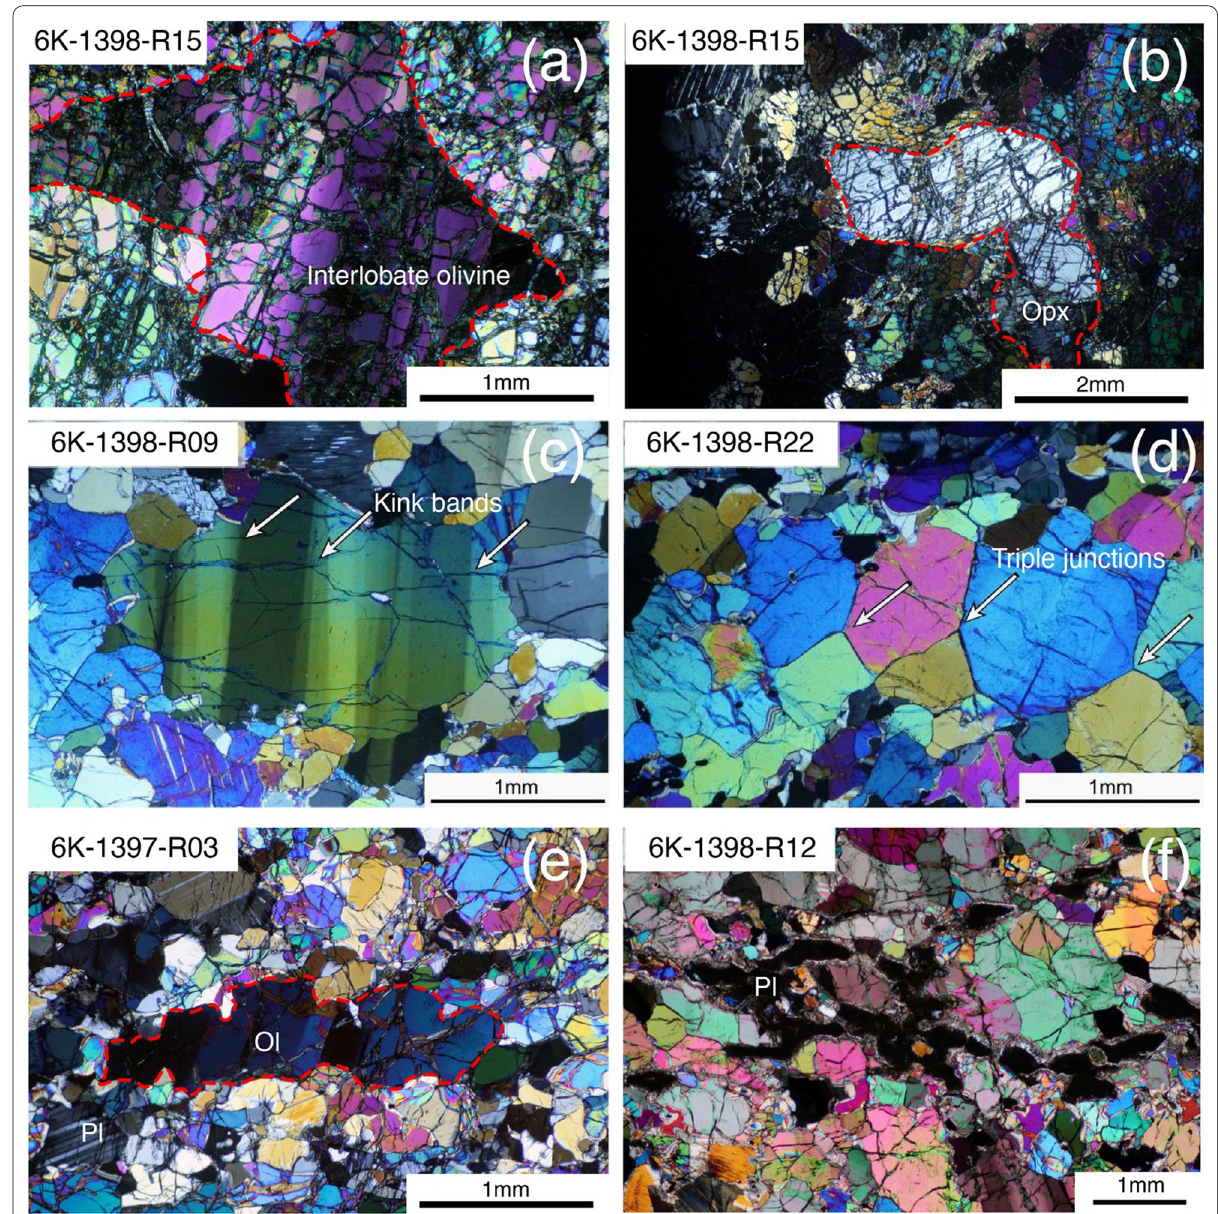
Fig. 5 Photomicrographs of 139°E Ridge peridotites under cross‑polarized light. The long side of each photomicrograph is parallel to the lineation. a Coarse‑grained texture showing interlobate olivine. b Coarse‑grained texture with irregularly shaped orthopyroxene (Opx). c Heterogeneous texture showing coarse olivine grains with undulose extinction and kink bands. d Heterogeneous texture showing olivine grains with polygonal textures and triple junctions. Pl: plagioclase. e Fine‑grained texture showing a larger olivine with serrated grain boundaries (Ol) that is elongate parallel to the lineation. f Fine‑grained texture showing grain boundaries in an orthopyroxene porphyroclast. Pl: plagioclase that appears as altered phases as irregular diffuse dark brown patches of